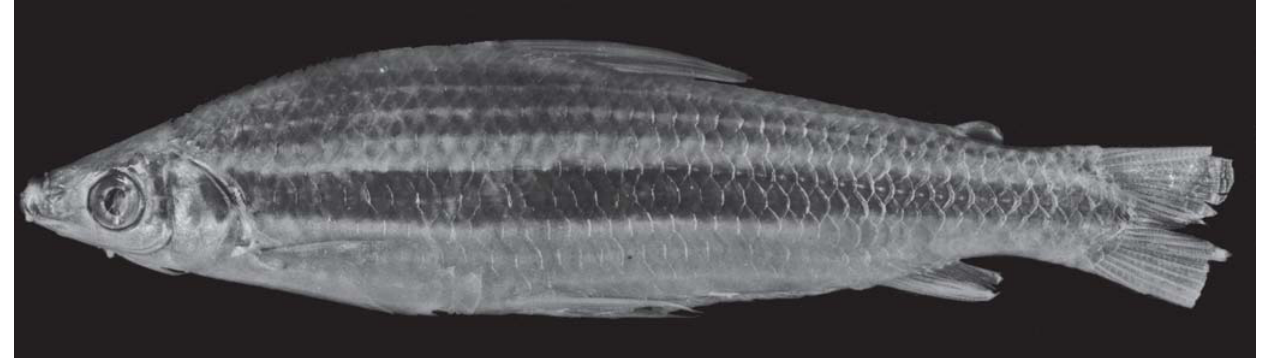
Fig. 23. Laemolyta taeniata , lectotype, NMW 81379: 2, 159.4 mm SL; Brazil, rio Guaporé.